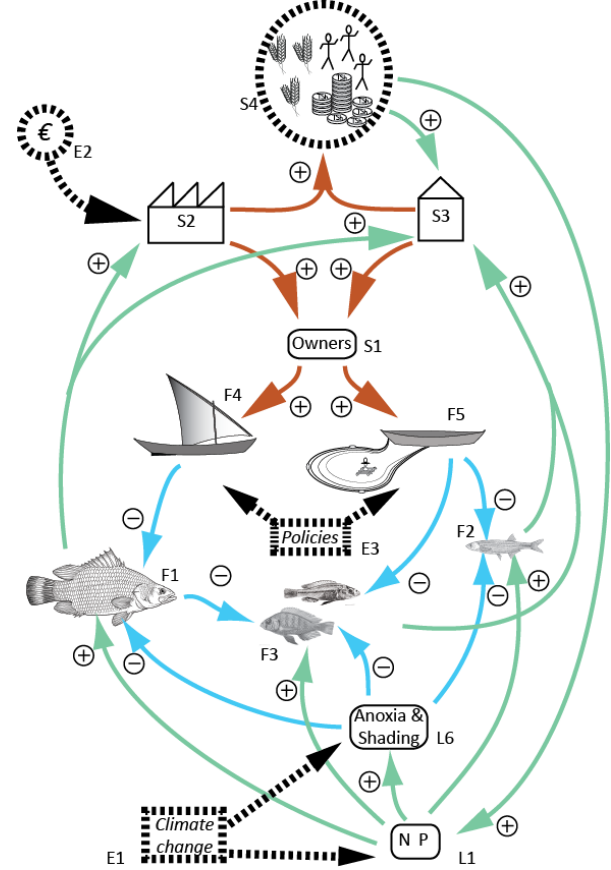
Fig. 3 . Social-ecological system interactions. Green arrows represent growth processes (also identified by + sign); blue arrows represent mortality processes (associated with - signs); rust arrows represent investment; thick dotted lines and arrows represent complex systems/interactions not further developed. E1 = climate change; E2 = international economy; E3 = policies; F1 = Nile perch; F2 = Rastrineobola argentea ; F3 = haplochromines; F4 = Nile perch fishing effort; F5 = R. argentea fishing effort; L1 = nitrogen and phosphorus; L6 = anoxia and shading; S1 = boat and camp owners; S2 = international market; S3 = local and regional market; S4 = local and regional economy and